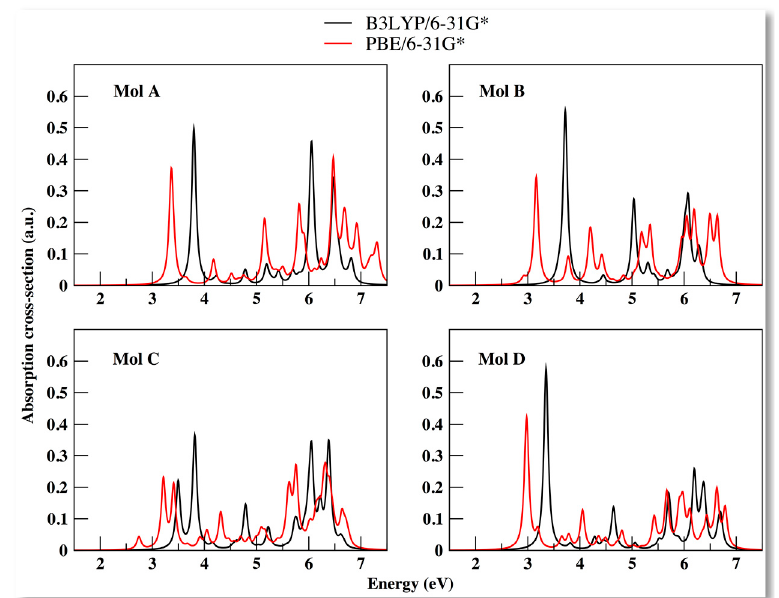
Figure 7. Calculated absorption spectra of coumarin derivatives using PBE XC functional (red) and B3LYP (black) and with 6-31G* basis set, respectively.